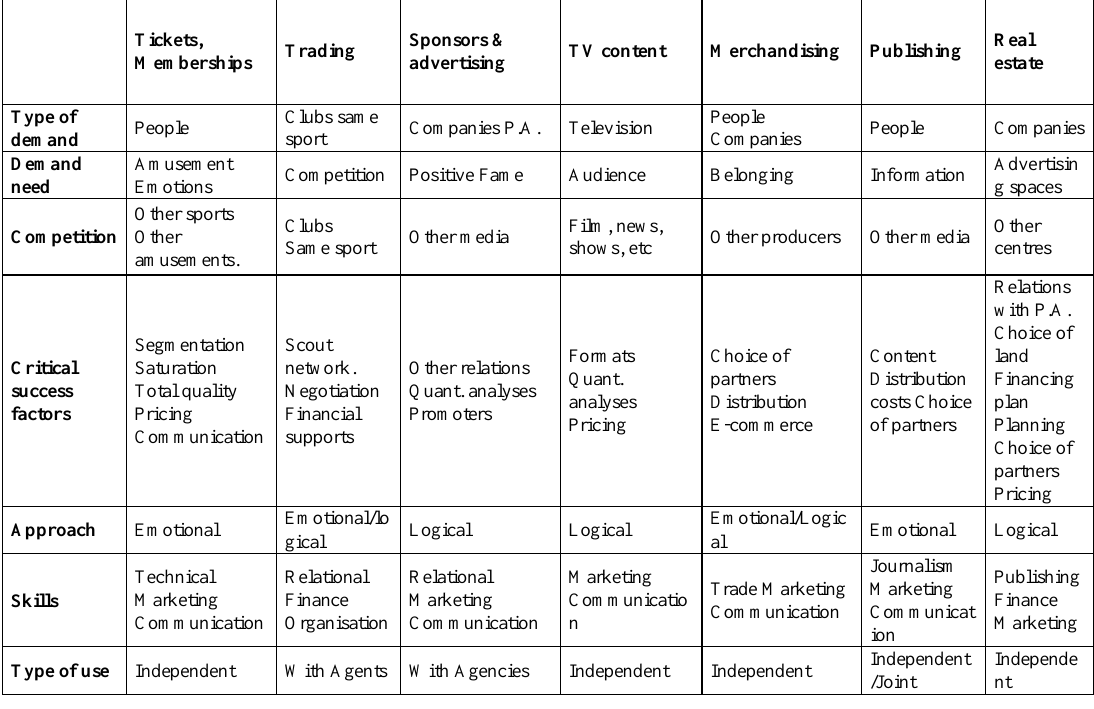
Figure 18: Sport Management. Comparative Picture of Business